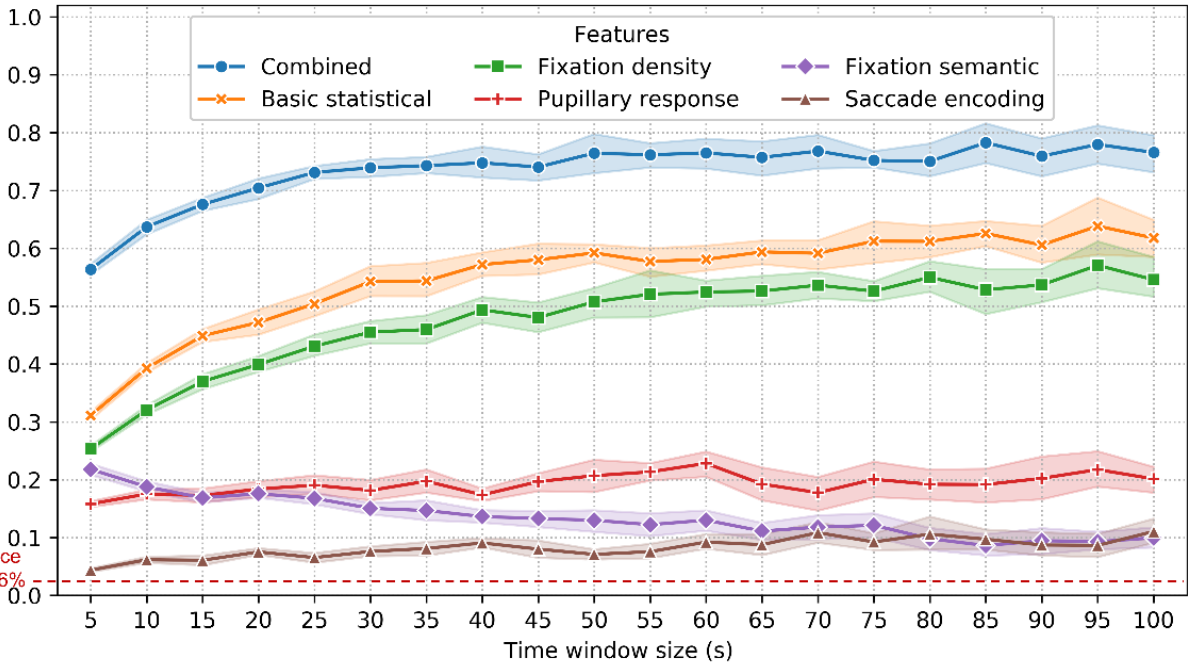
Figure 8. ROC ( left ) and CMC ( right ) curves in the 10-fold classification (T win = 85 s). 4.2. Identification Scenario: LORO Classification The accuracy when using the LORO method is shown in Figure 9. Since the classifier learned no information about the testing environment in this method, it is unsurprising that the accuracy when using the LORO method for identification is lower than that when using the 10-fold classification (Figure 7). However, the relative performance between the six feature sets was the same as in the 10-fold classification. The combined features achieved an accuracy between 37% (T win = 5 s, SD = 8.9%) and 64% (T win = 100 s, SD = 13.0%), followed by the basic statistical (25~52%; SD = 4.4~11.4%), fixation density (17~43%; SD = 3.0~12.1%), pupillary response (12~17%; SD = 1.4~4.0%), fixation semantic (7~9%; SD = 2.3~4.0%) and saccade encoding features (4~8%; SD = 0.5~3.2%). The ROC and CMC curves when T win = 80 s are shown in Figure 10. When T win = 80 s, the best EER of 12.2% was exhibited by the combined features with Rank-1 IR = 62%, fol- lowed by the basic statistical (EER = 16.5%, Rank-1 IR = 50%), fixation density (EER = 19.4%, Rank-1 IR = 42%), pupillary response (EER = 27.3%, Rank-1 IR = 14%), fixation se- mantic (EER = 36.7%, Rank-1 IR = 8%) and saccade encoding features (EER = 41.1%, Rank- 1 IR = 8%). The best accuracy of 64% (EER = 12.1%) achieved by the combined features was mod- erate, considering that the identification was performed in completely new environments.